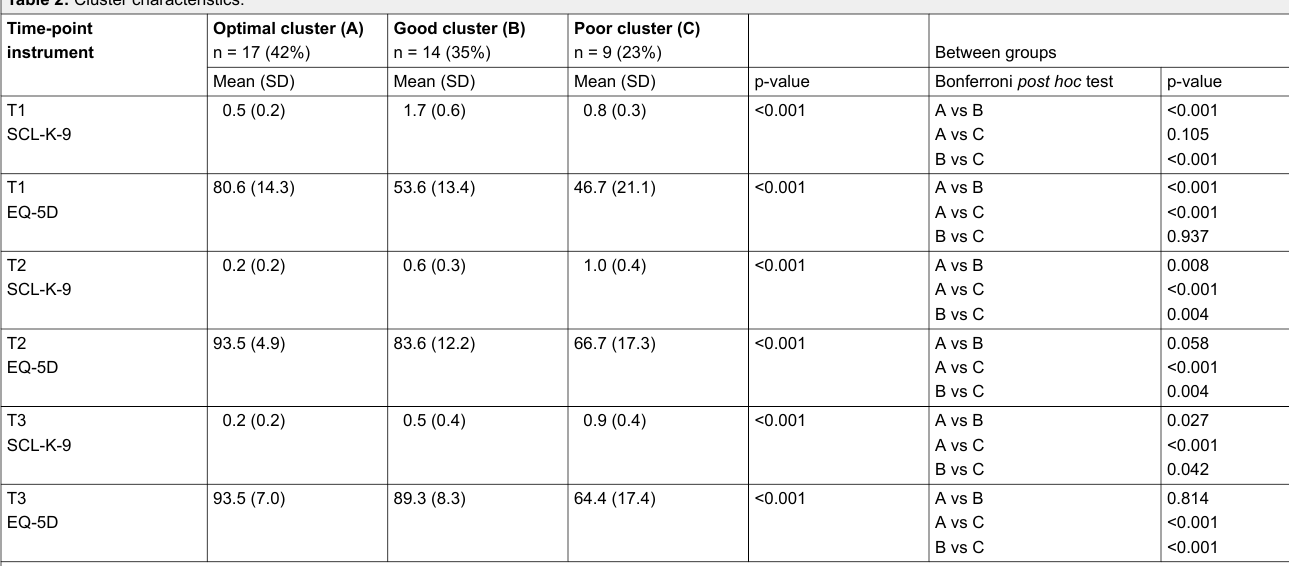
Table 2: Cluster